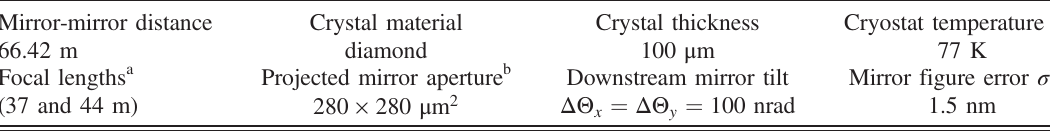
TABLE II. Cavity and x-ray optics parameters used for simulation.